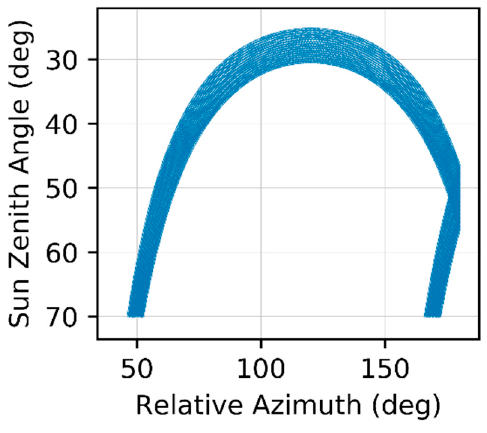
Figure 3. Sun zenith angle and sun-sensor relative azimuth corresponding to all radiometric measurements collected during the 18-day experiment.